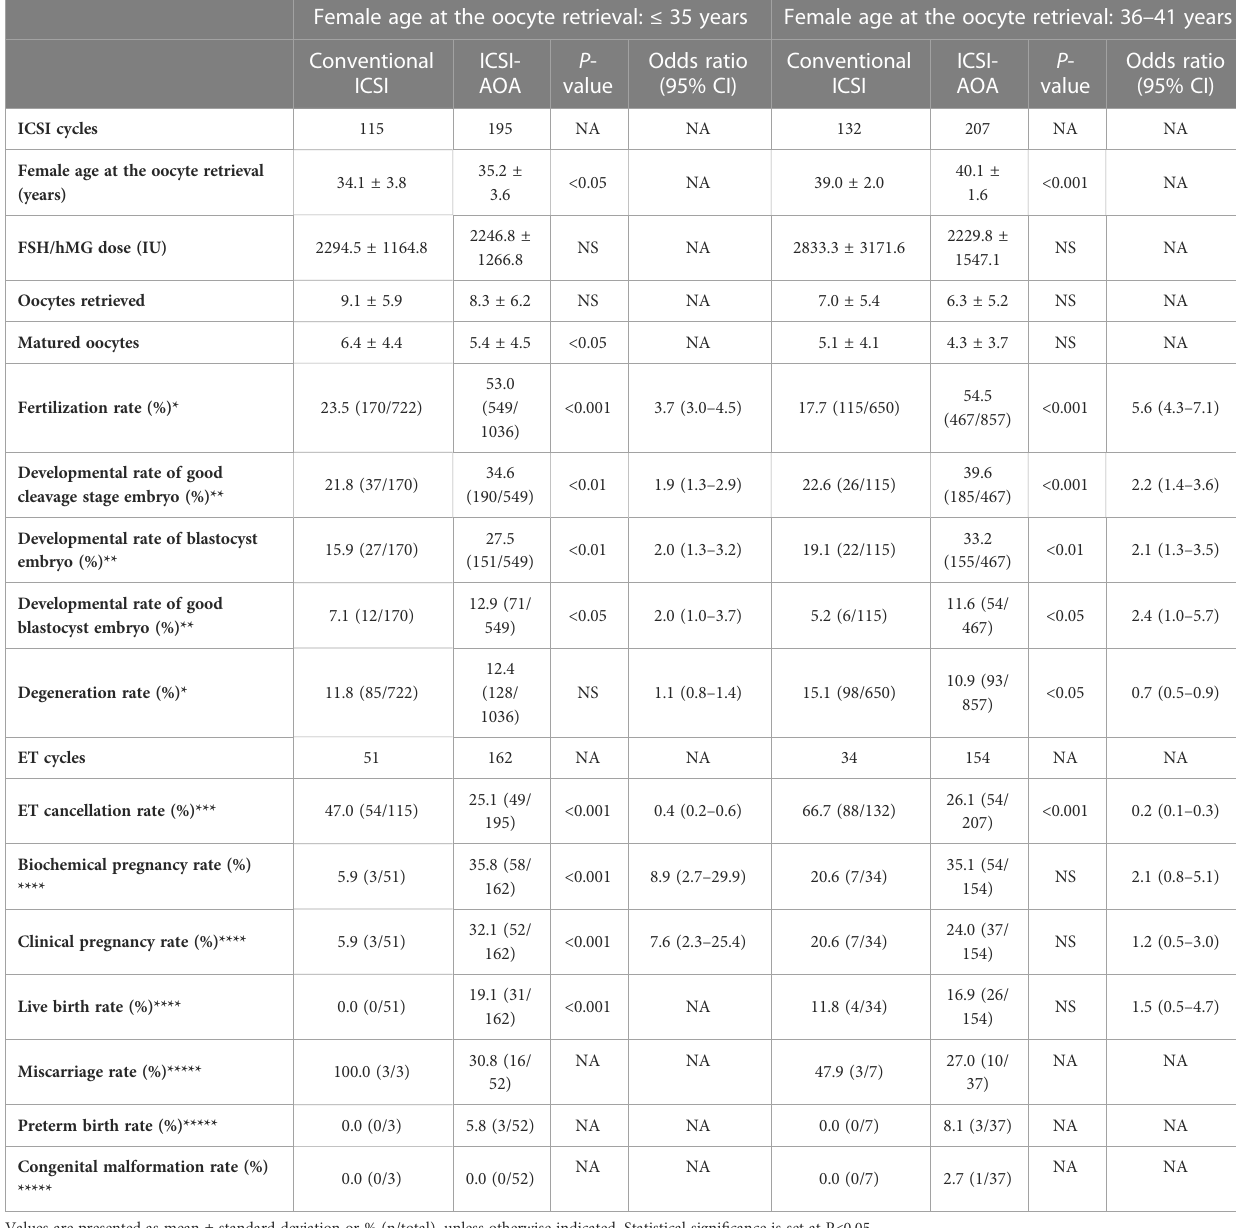
TABLE 2 Embryological and clinical outcomes after intracytoplasmic sperm injection (ICSI) and subsequent arti fi cial oocyte activation (AOA) treatment according to patient